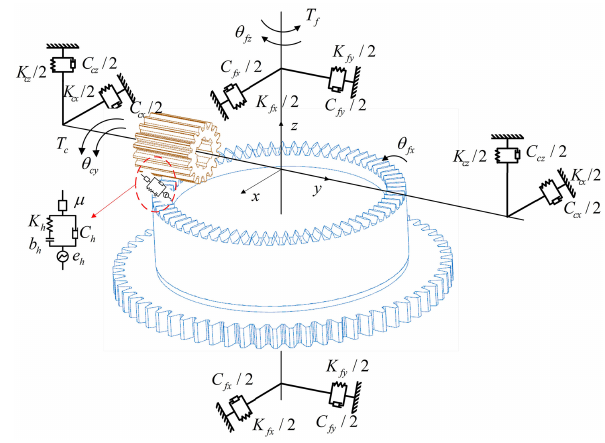
Figure 1. Kinematics model of single-stage face